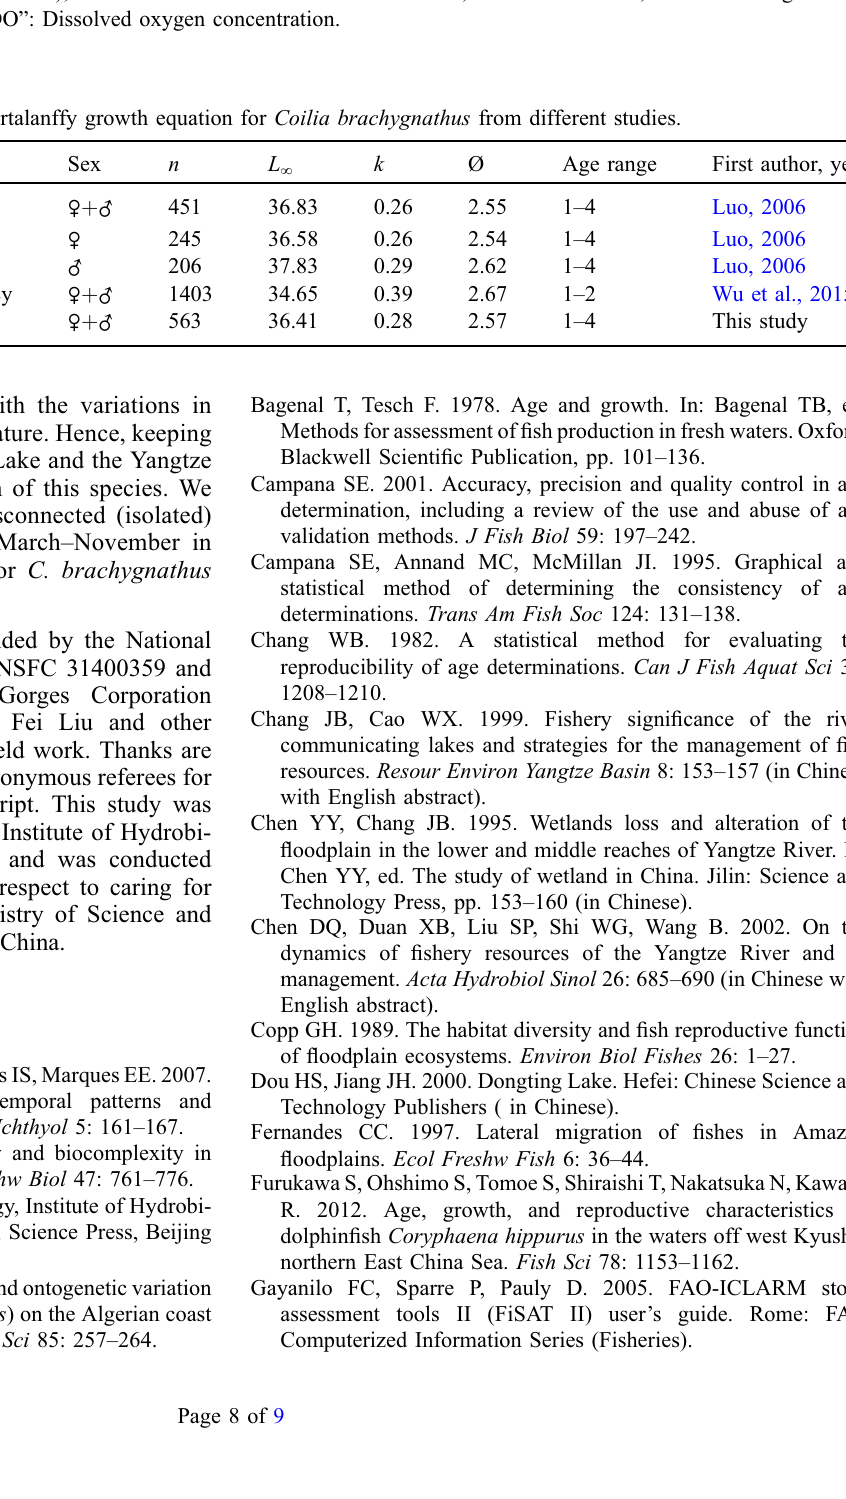
** Correlation is signi fi cant at the 0.01 level (2-tailed); “ V- ” : the variation of environmental factors; “ WL ” : Water level; “ DC ” : Discharge “ WT ” : Water temperature; “ FV ” : Flow velocity; “ DO ” : Dissolved oxygen concentration.